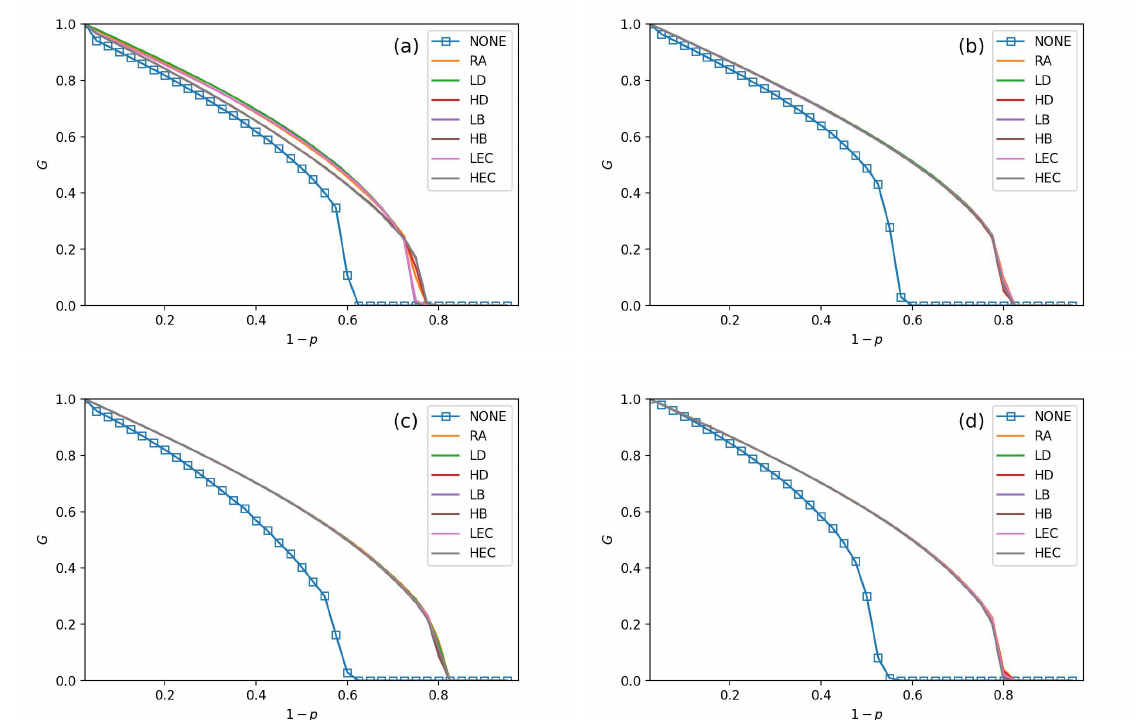
Figure 6. The fraction of function nodes when f L = 45% in ER-ER, ER-SF, SF-ER, and SF-SF system, which is shown in ( a – d